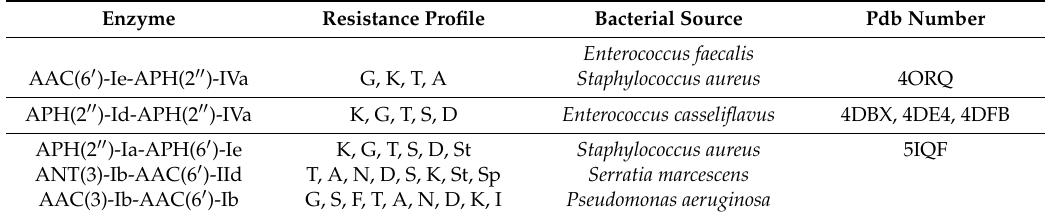
Table 4. Bifunctional modifying